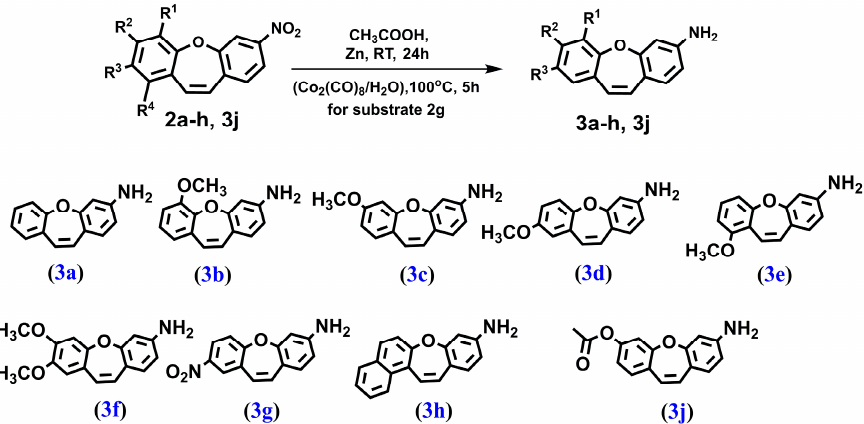
Figure 8. The structure of: dibenzo[ b,f ]oxepin-3-amine ( 3a ), 6-methoxydibenzo[ b,f